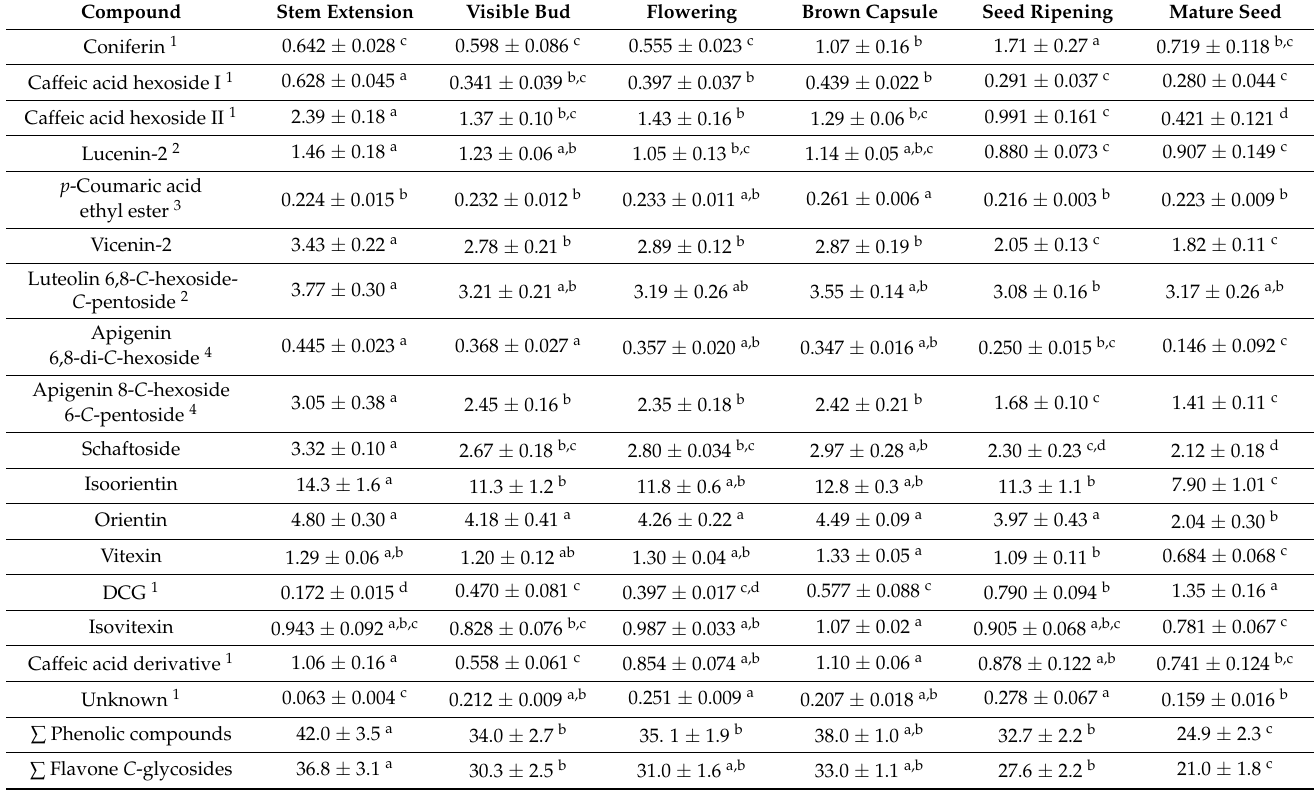
Table 3. Contents of the individual phenolic compounds in the extracts of flax harvested at different growth stages (mg/g